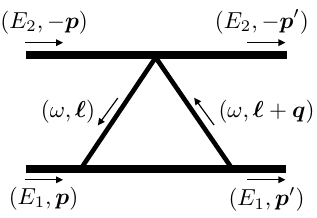
Figure 15 . The triangle diagram. The thick and thin lines represent massive and massless particles,